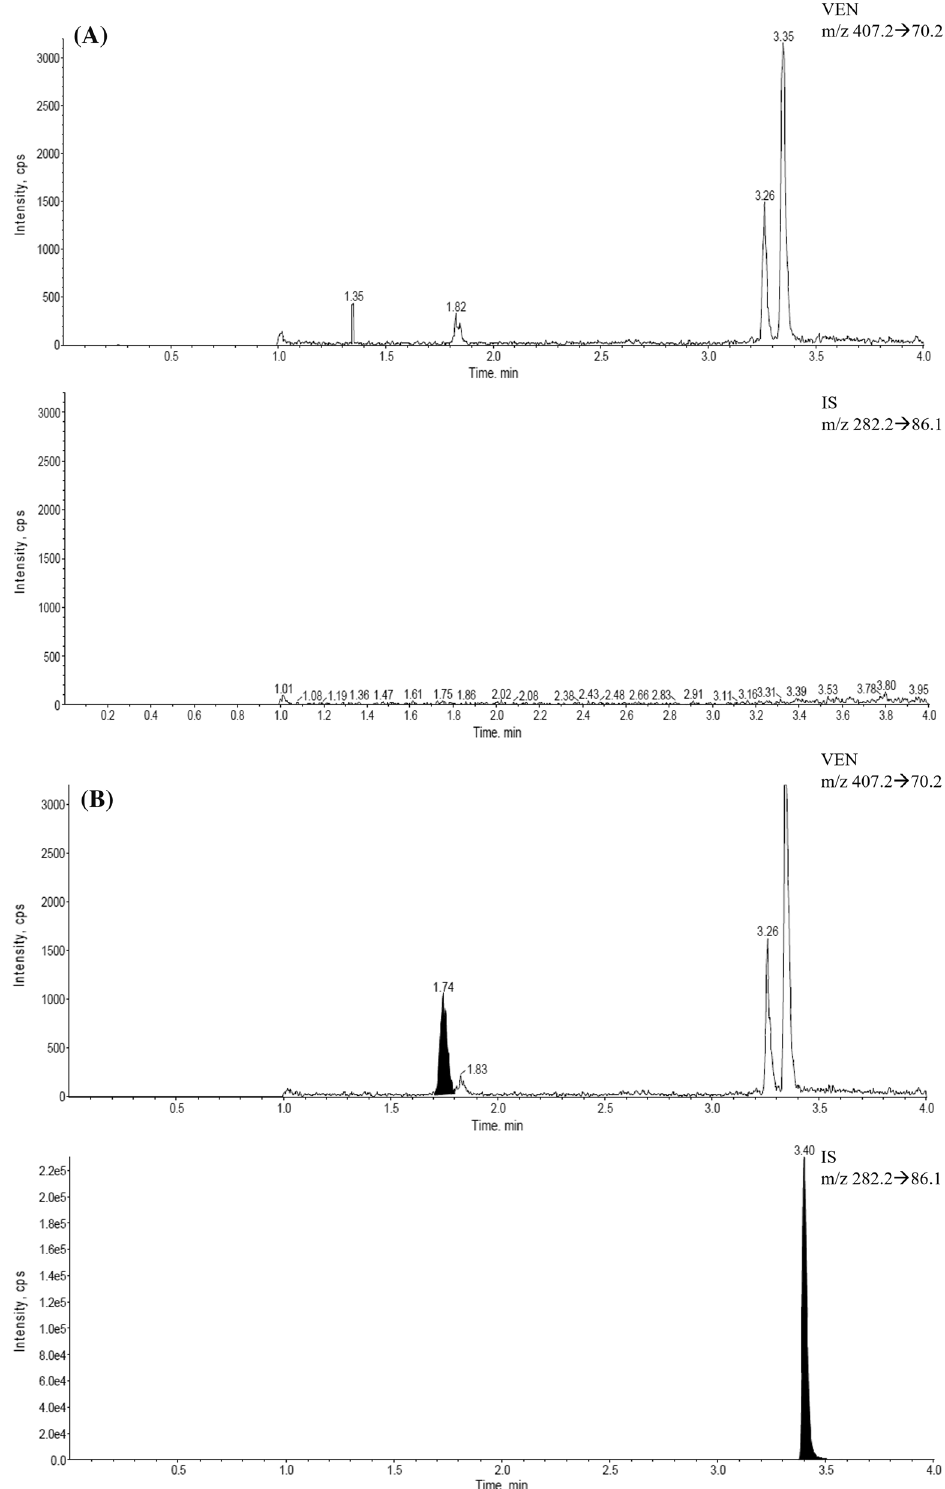
Fig. 2 MRM chromatograms for samples in the rat plasma. A Double blank; B VEN at LLOQ with IS; C VEN at the ULOQ with IS. MRM chromatograms for samples in the dog plasma. D Double blank; E VEN at LLOQ with IS; F VEN at the ULOQ with